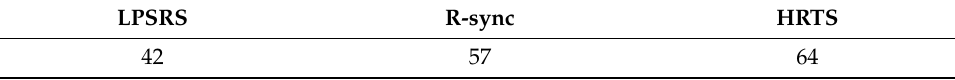
Table 1. Comparison of LPSRS, R-sync, and HRTS.